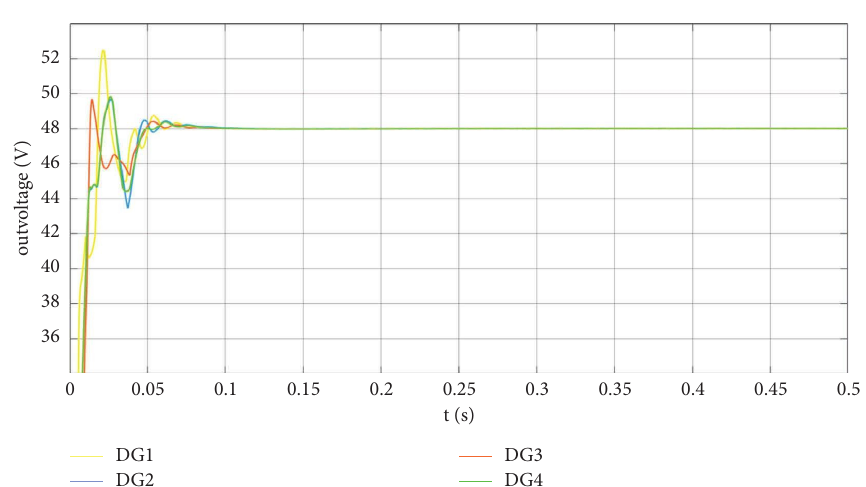
Figure 7: Output voltage under proportional current